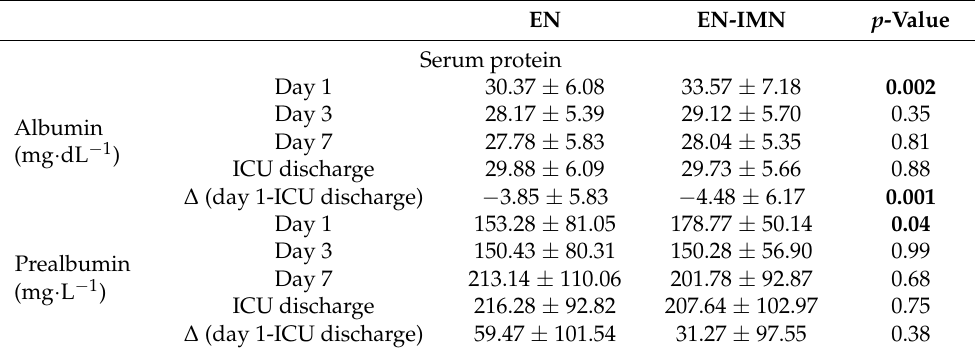
Table 7. Laboratory markers of the different subgroups measured during nutritional